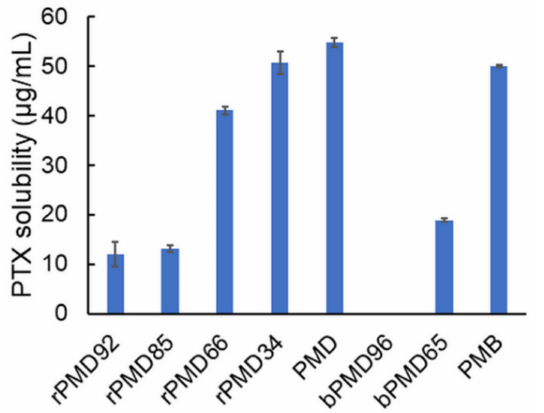
Figure 4. PTX solubility of MPC polymers at 1